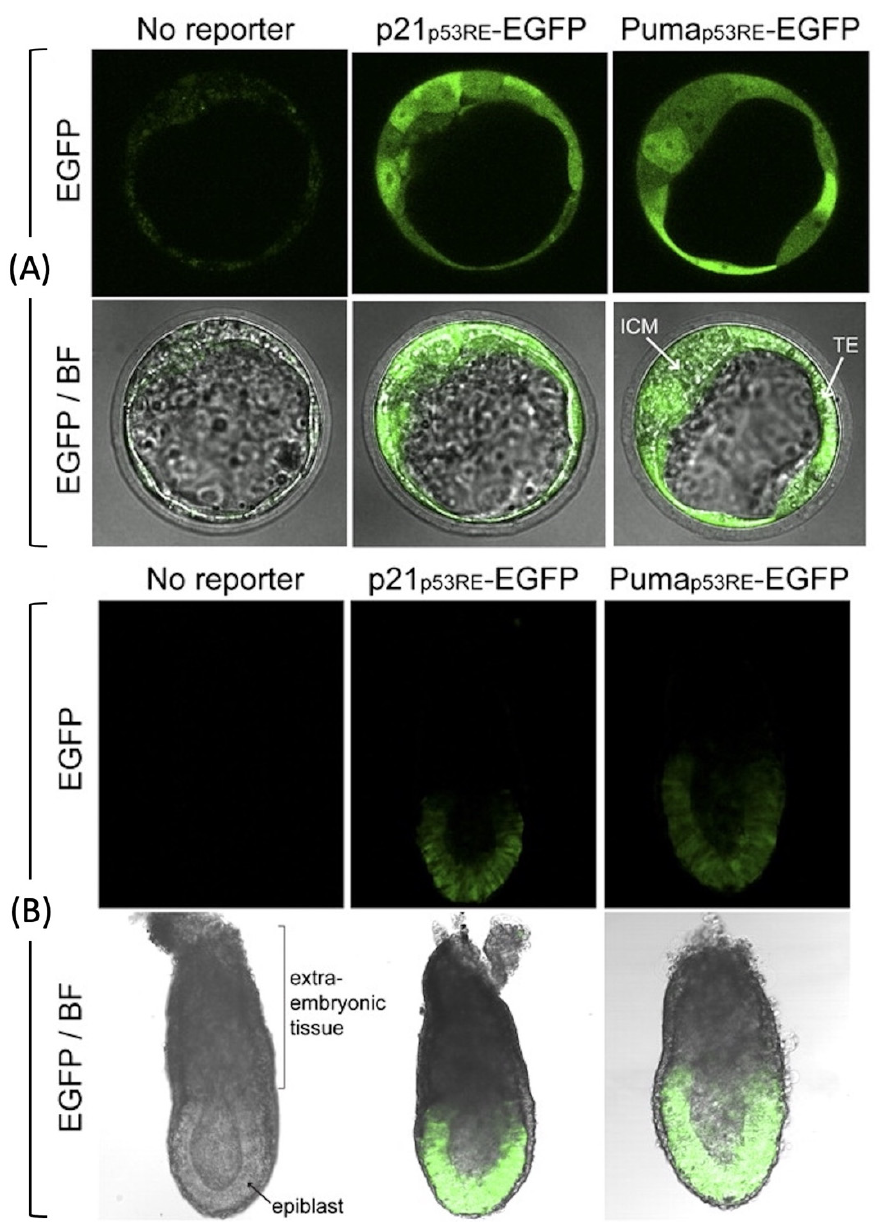
Figure 3. p53 transcriptionally activity at the beginning of mouse development. p53 activity was assayed in early stage embryos isolated from mice homozygous for reporter genes expressing enhanced green fluorescence protein (EGFP) from either the p21 gene’s p53 response element or the Puma gene’s p53 response element and examined immediately by confocal microscopy, adapted from [47], with the permission from Proc. Natl. Acad. Sci. USA, 2012. ( A ) At embryonic day E3.5, EGFP fluorescence was detected in all blastocyst cells, including the inner cell mass (ICM), and trophectoderm (TE). The large blastocoel cavity identifies these examples as late-stage blastocysts. ( B ) EGFP fluorescence was also detected in E6.5 post-implantation reporter embryos but only in the epiblasts and not in the extraembryonic tissues. BF indicates bright field microscopy.